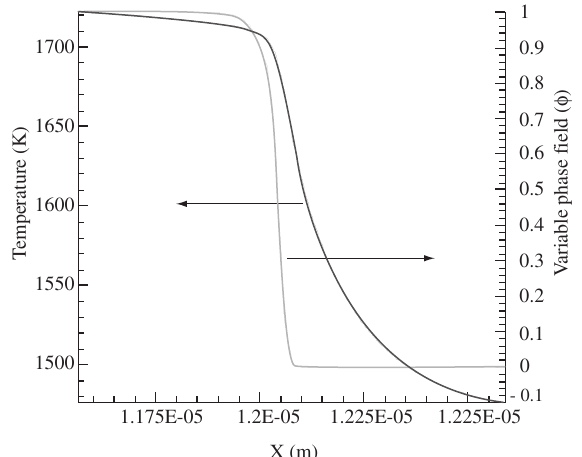
Figure 7. Temperature and phase-field variable profiles across the solid/liquid